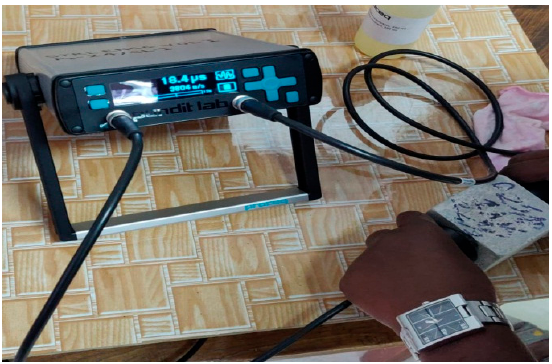
Figure 6. UPV testing setup to test blended cement mix mortar samples.